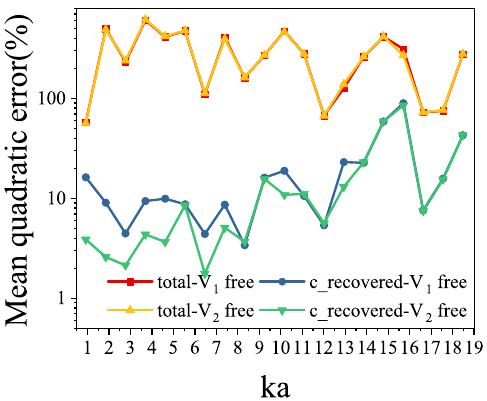
Figure 6. Mean quadratic errors on the measurement